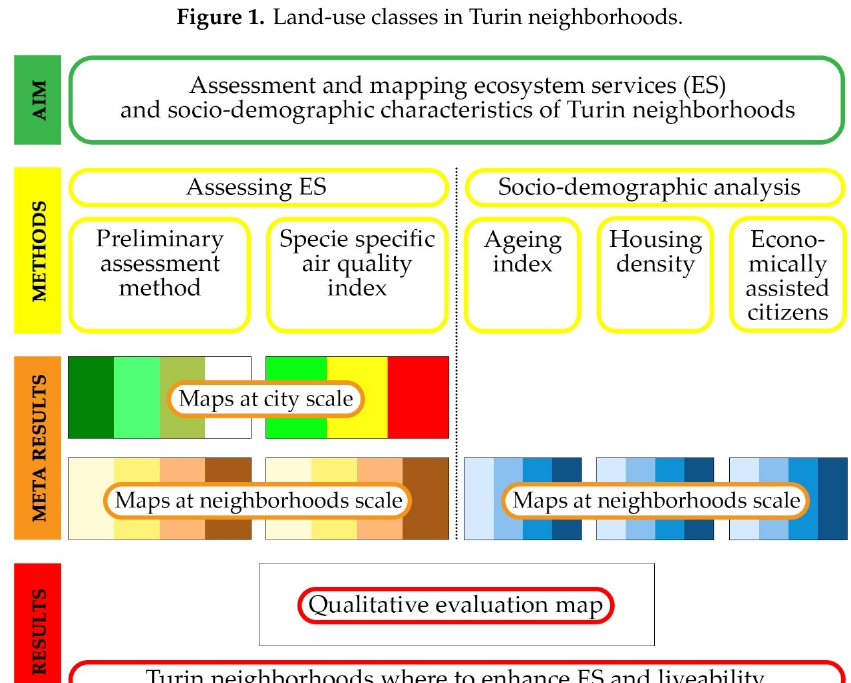
Figure 2. Methodological framework of the research.